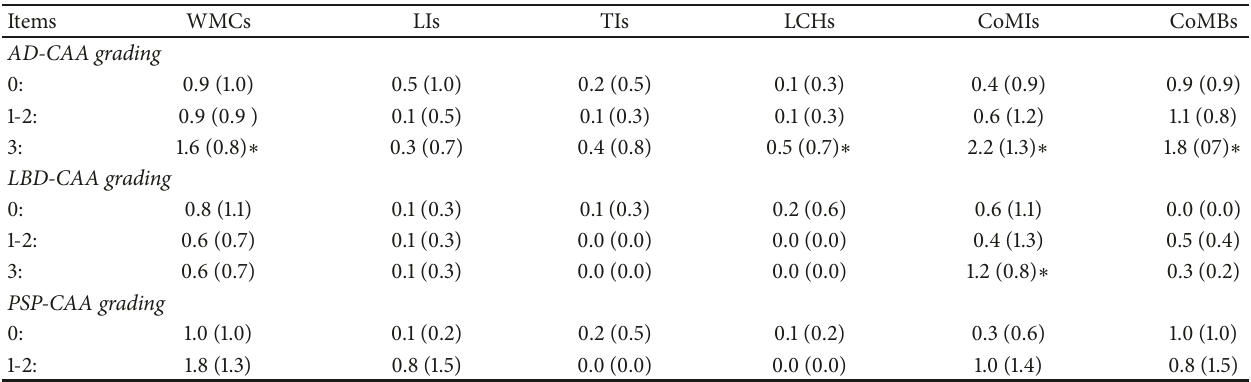
Table 3: Semiquantitative analysis of the severity of white matter changes (WMCs), lacunar infarcts (LIs), territorial infarcts (TIs), cerebral lobar haematomas (CLHs), cortical microinfarcts (CoMIs), cortical microbleeds (CoMBs) in Alzheimer’s disease (AD), Lewy body disease (LBD), and progressive supranuclear palsy (PSP) according to the grading of the severity of cerebral amyloid angiopathy (CAA).